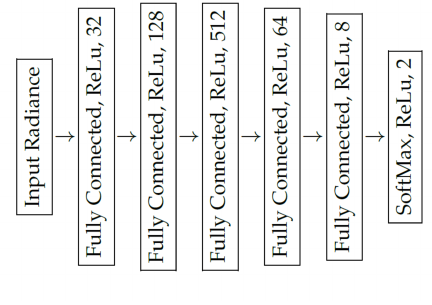
Figure 8. Layout of the deep neural network applied for classification. Algorithm 1: Automatic annotation of hyperspectral